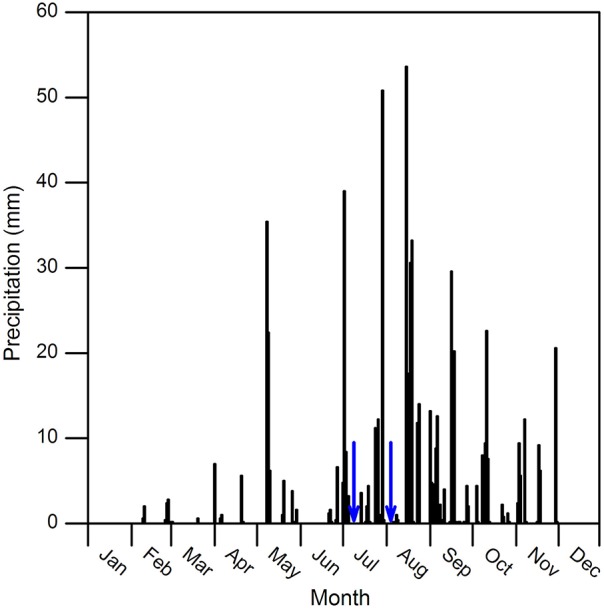
Precipitation data recorded at the meteorological station close to the experimental area (ca. 250 m) in 2011. Blue arrows indicate dates for watering.